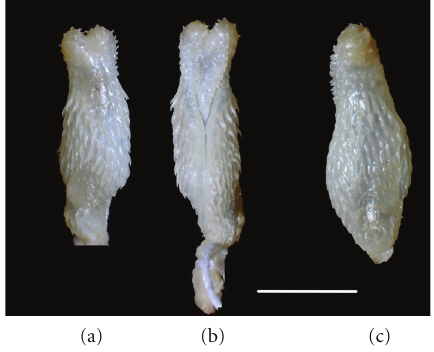
Figure 2: Hemipenis of Sordellina punctata (IBSP 71106). (a) asulcate side; (b) sulcate side; (c) lateral view. Bar = 5 mm.